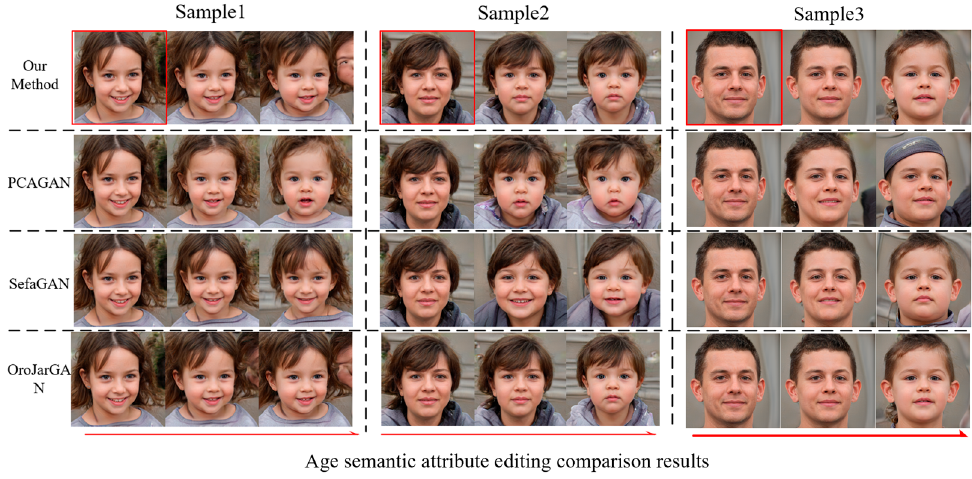
Figure 11. FFHQ dataset faces age semantic attribute editing comparison results.